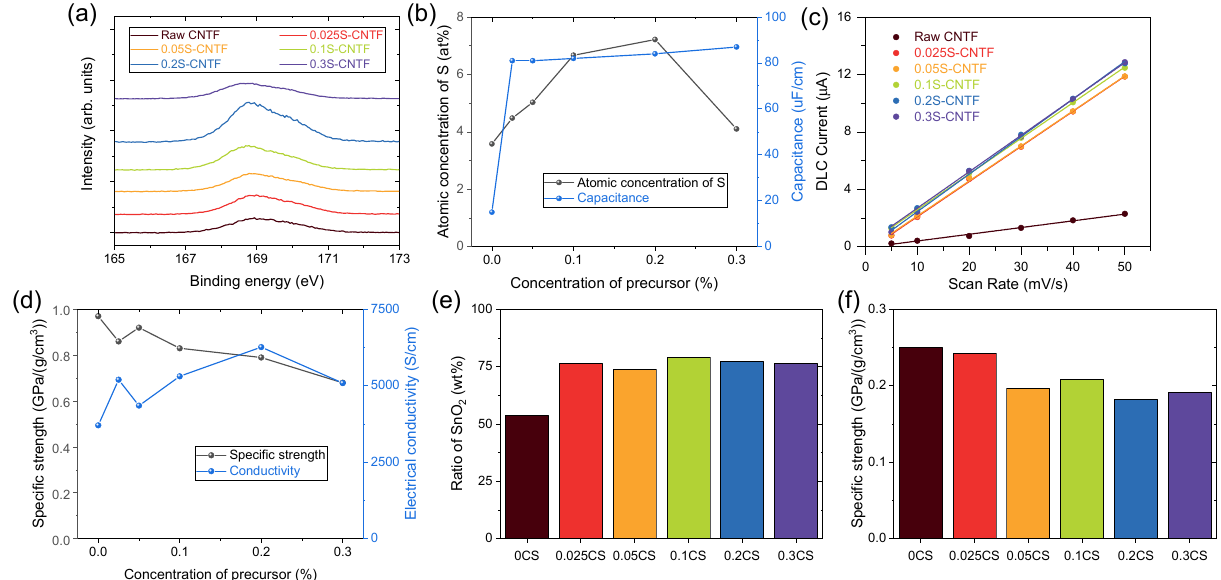
Figure 2. ( a ) S2p XPS spectra of CNTF and ( b ) quantitative analysis of sulfur and capacitance of the CNTF. ( c ) Capacitive currents of CNTF versus scan rate. ( d ) Specific strength and conductivity of CNTF. ( e ) Ratio of SnO 2 and ( f ) specific strength of SnO 2 @CNTF.